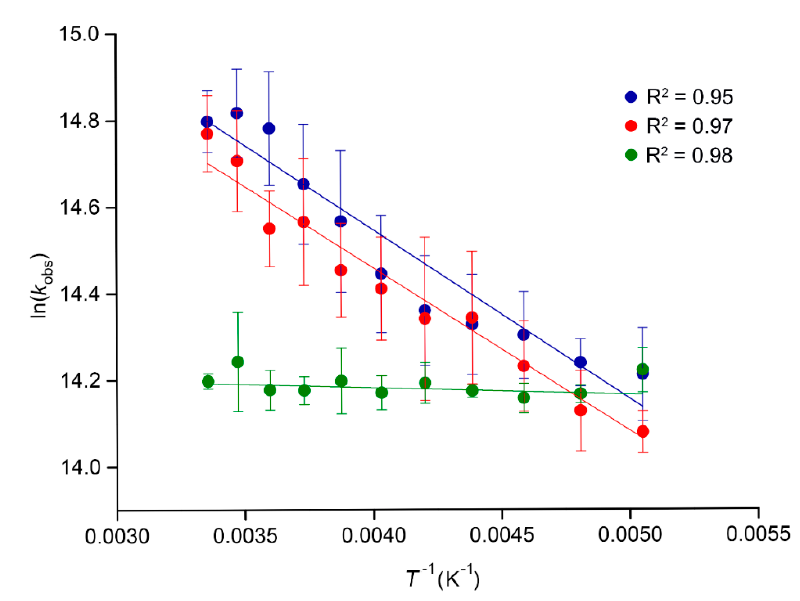
Figure 4. Arrhenius plot for [Ir( ppy ) 2 ( TzPyNHC 16cis )] (blue), [Ir( ppy ) 2 ( TzPyNH 2 )] (red), and [Ir( ppy ) 2 ( TzPyCN )] (green), obtained from measurements in air-equilibrated diluted dichloromethane solutions. Error bars are reported as standard deviation of three independent measurements.